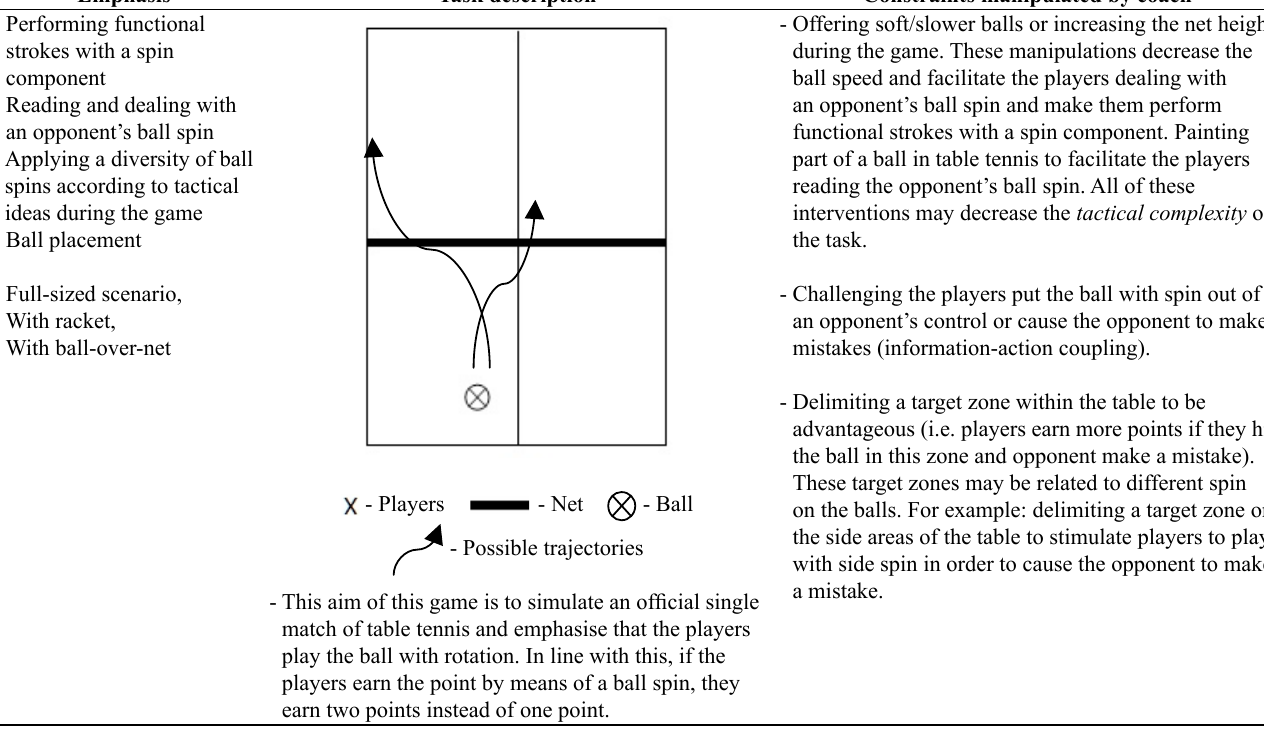
Table II. Design of representative training tasks focused on ball spin skills for beginner players of table tennis.